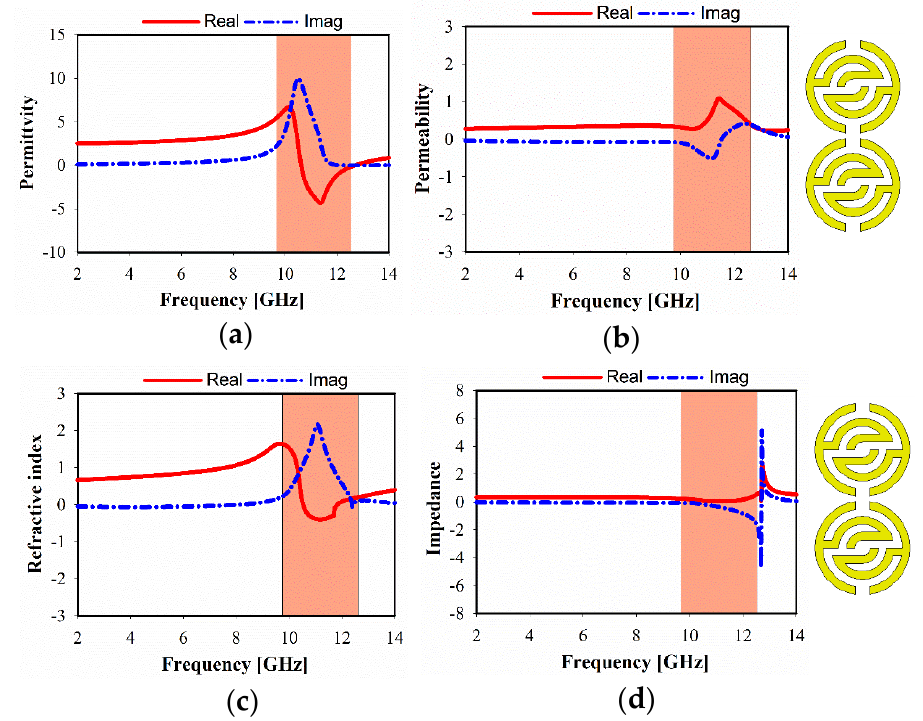
Figure 6. Metamaterial, simulated results of 1 × 1 unit cell: ( a ) permittivity, ( b ) permeability, ( c ) refractive index, and ( d ) impedance.